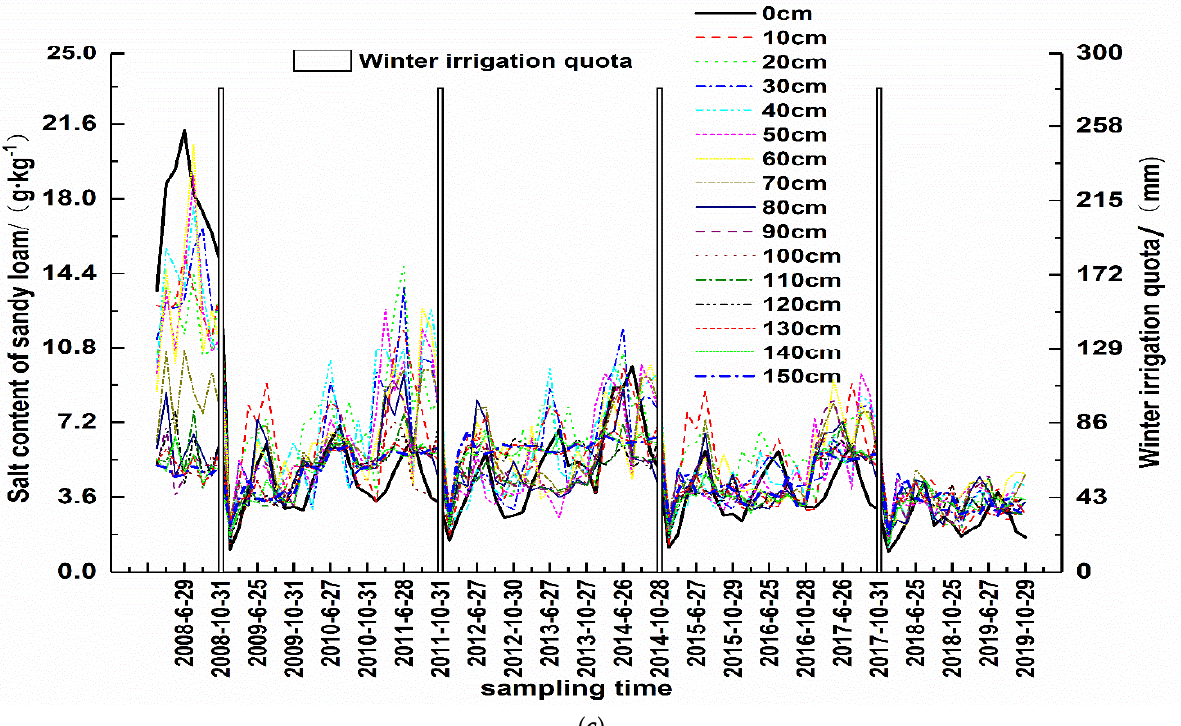
Figure 4. The average salt content of each observation layer of different soil types. ( a ) Loamy clay; ( b ) loam; ( c ) sandy loam.